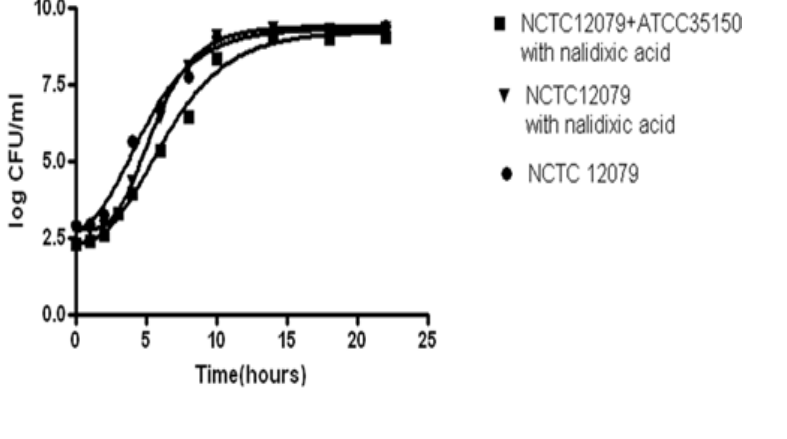
Figure 5. Comparison of growth curves of a mixture of two E. coli O157:H7 NR strains (NCTC12079 NR and ATCC35150 NR ) and E. coli O157:H7 NR strain (NCTC12079 NR ) and E. coli O157:H7 parent strain in broth at 36